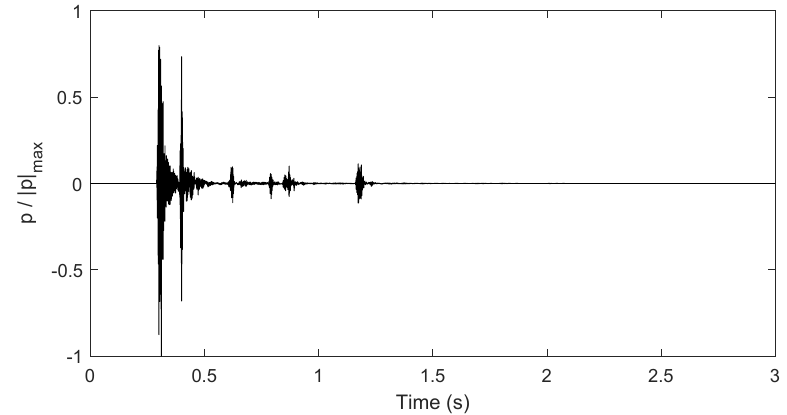
Figure 13. Impulse response computed at the receiver without mitigation